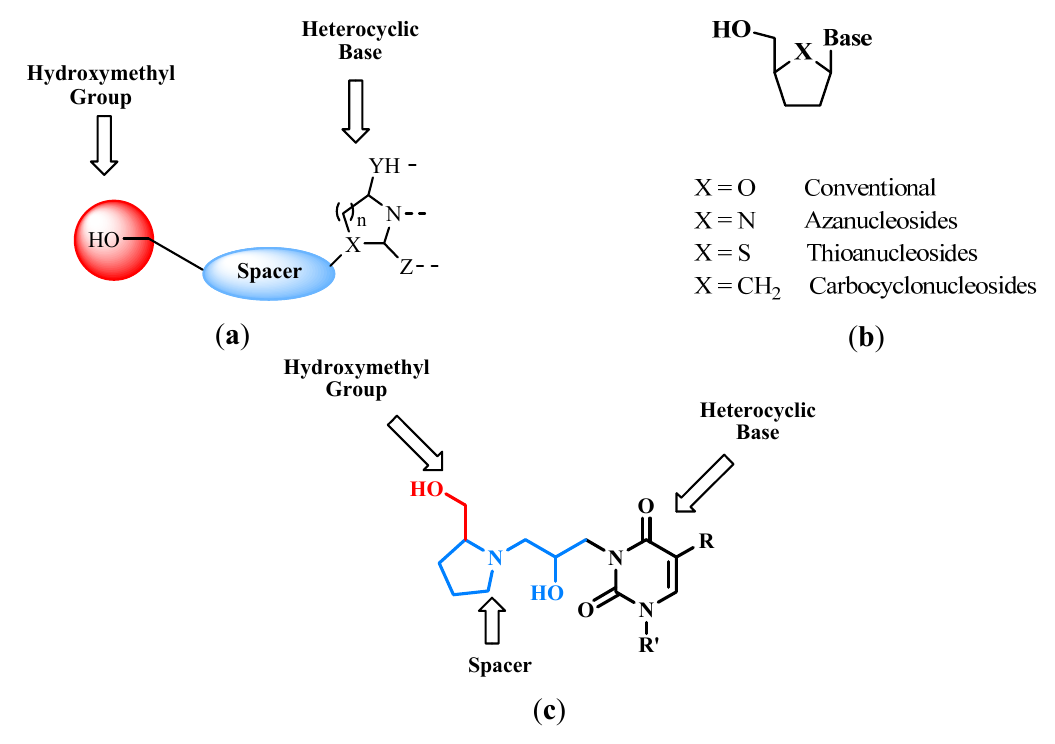
Figure 2. Sulphated zirconia